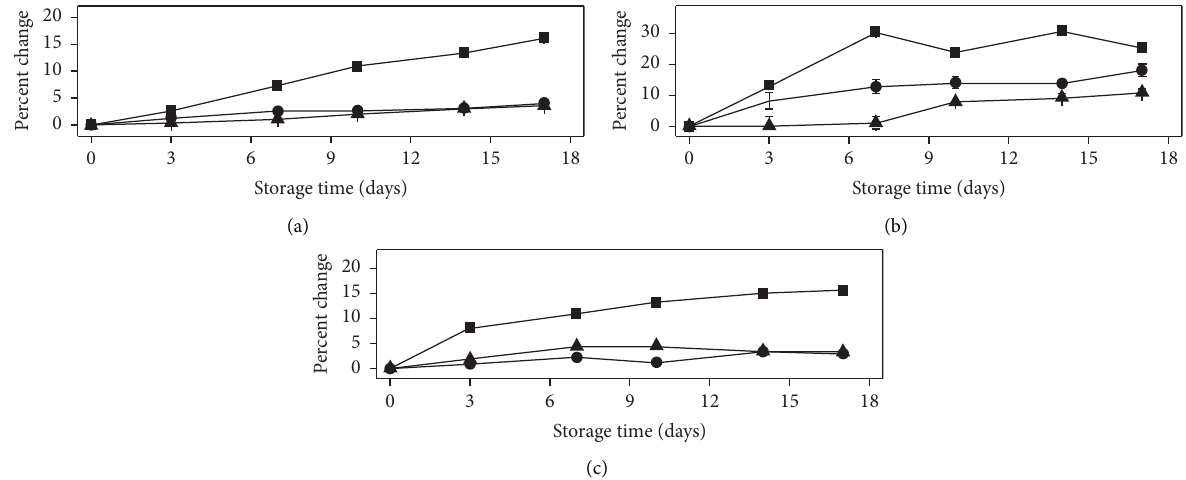
Figure 1: Changes in weight (a), frmness (b), and colour (c) of eggplant fruit during cold storage (control fruit ( ■ ); beeswax-coated fruit ( ● ); citrate-treated beeswax-coated-fruit ( ▲ )).